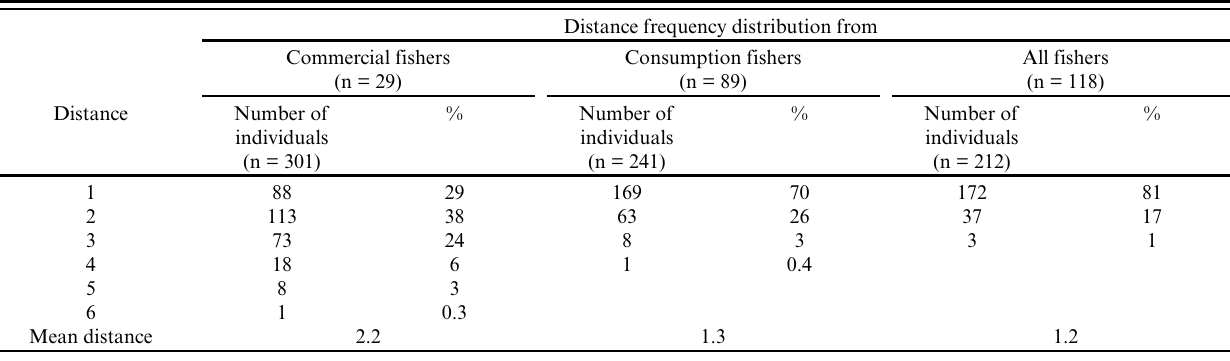
Table 4 . Distance frequency distributions and mean distance between fishers and the villagers in the main component of the community strong-tie network (n = 330).